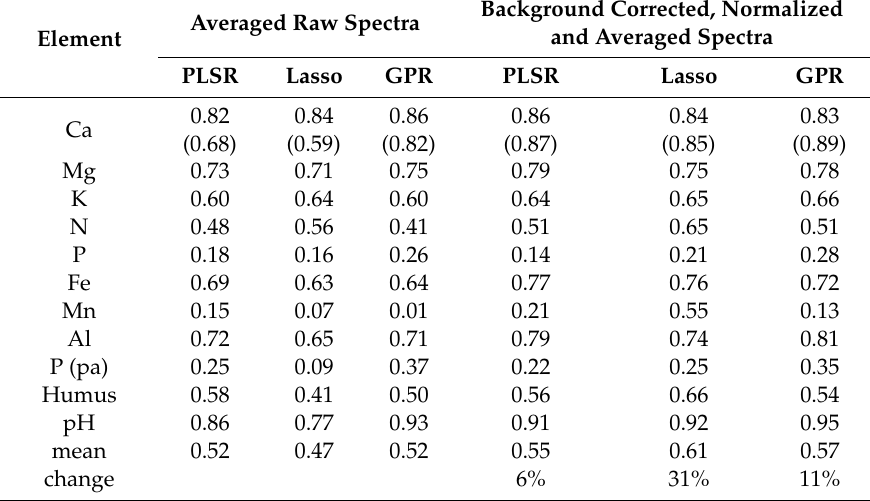
Table 4. E ff ect of background correction and normalization of spectra on multivariate methods, reported as coe ffi cients of determination, in the case of Ca, values in parentheses show the e ff ect of using the logarithms of the mass fractions. Background Corrected, Averaged Raw Spectra Element